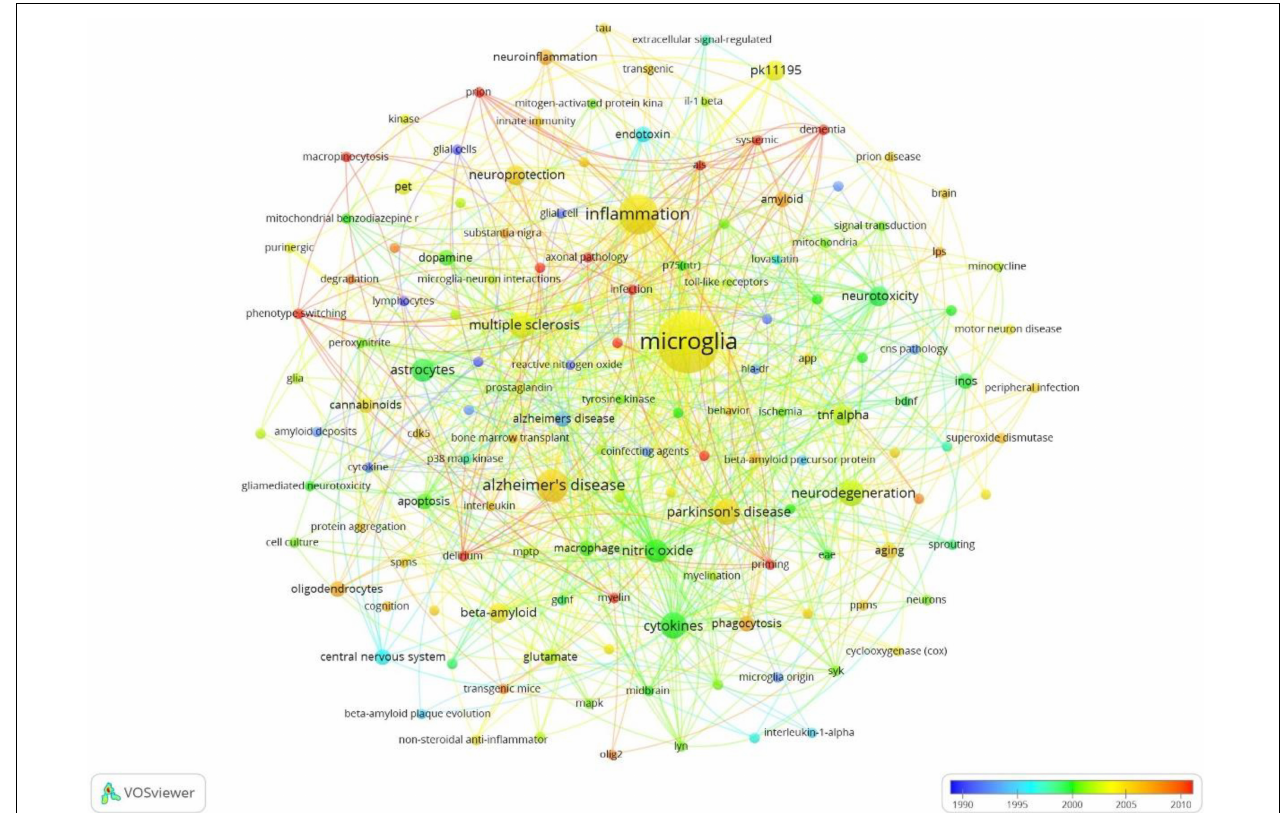
FIGURE 11 | Co-occurrence analysis of frequently occurred author keywords, weighed by occurrence, visualized timeline map.